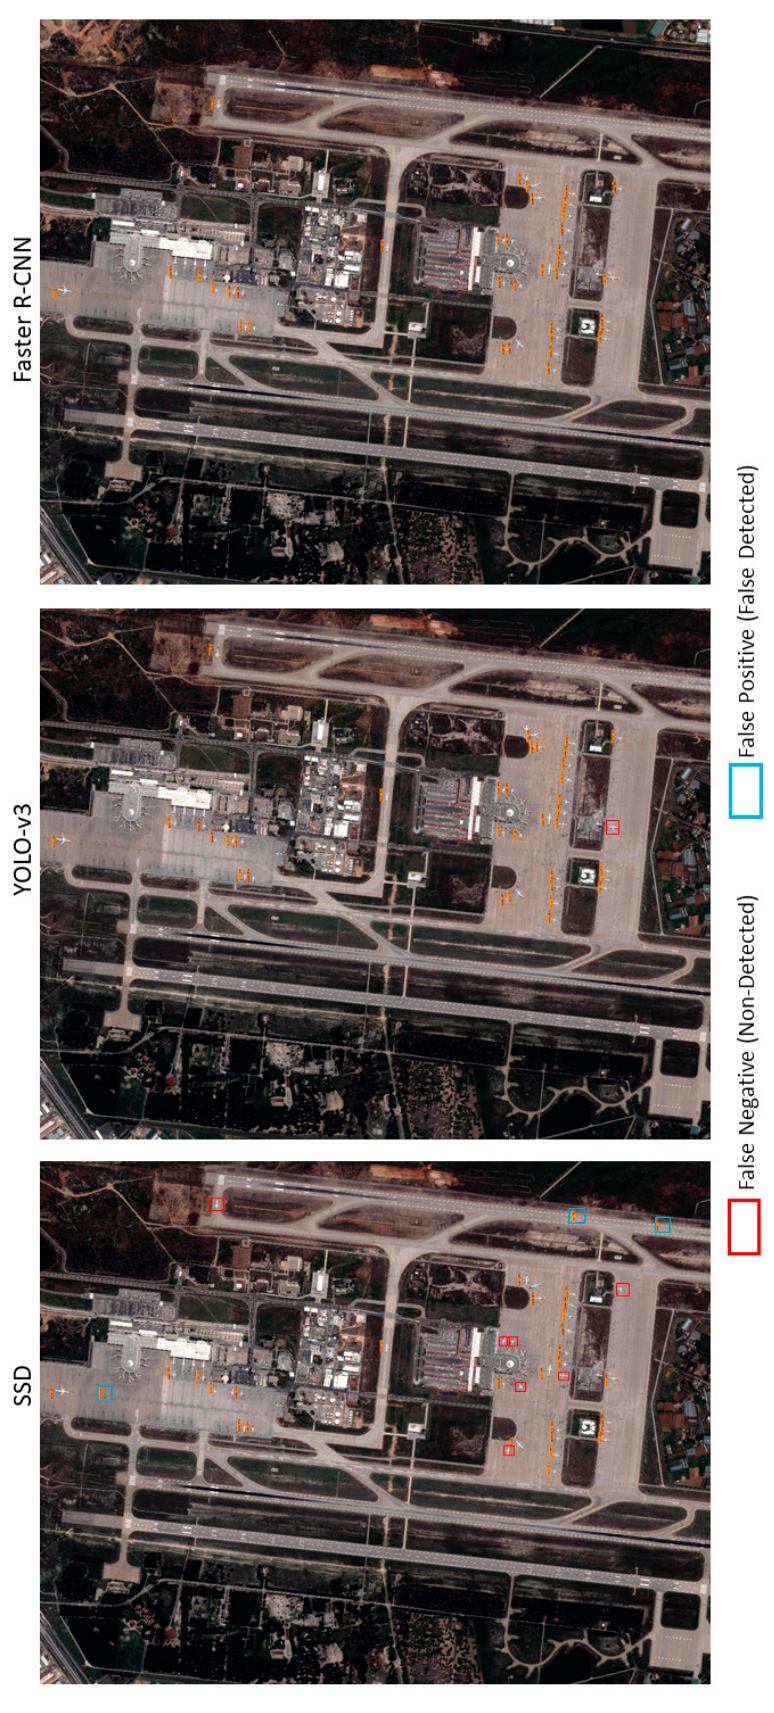
Figure A5. The aircraft detection results of Antalya Airport from Pleiades image data.